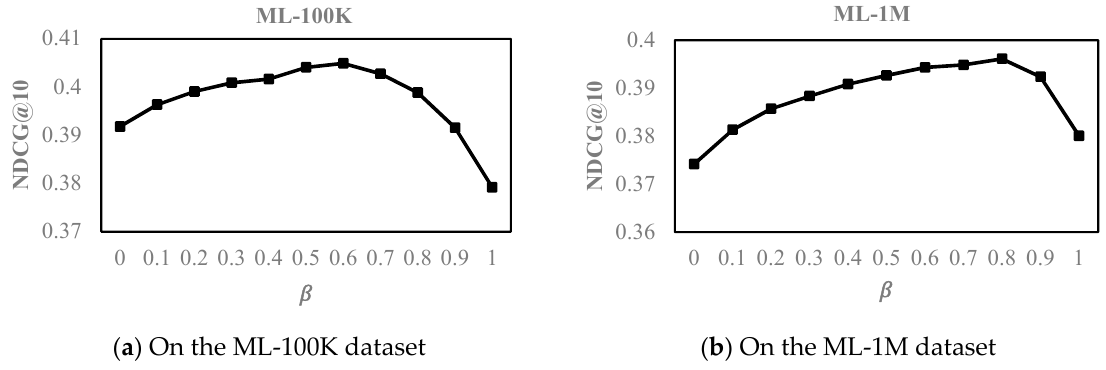
Figure 6. Performance of β based on NDCG@10.